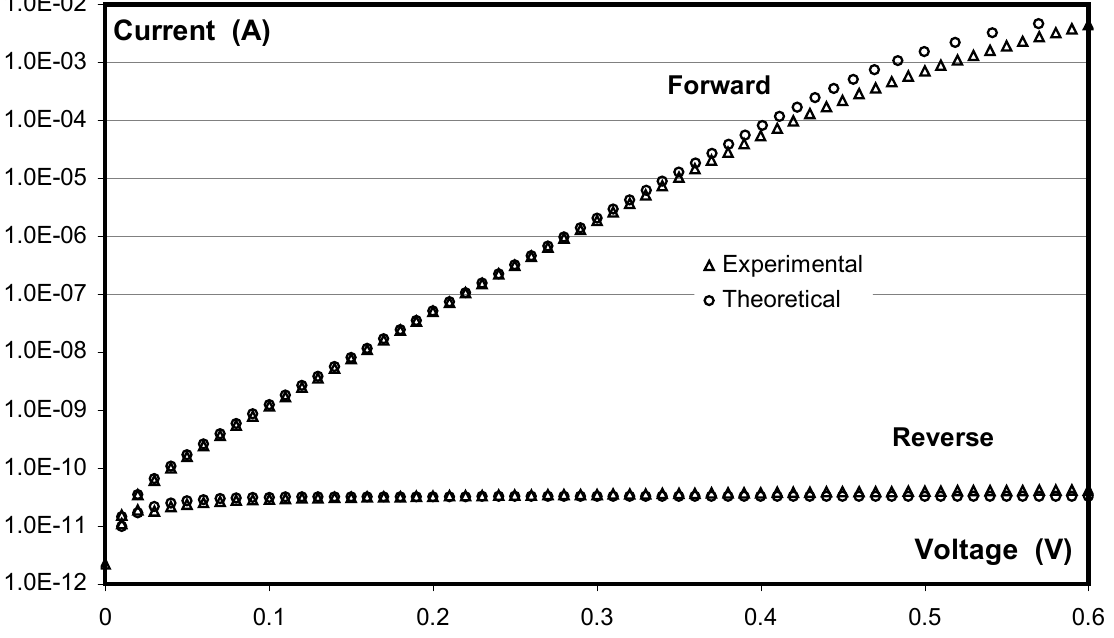
Figure 6. Close comparison between the experimental I-V curves and the theoretical ones in the dark. Only minor discrepancies appear under forward polarity at moderate applied voltages.